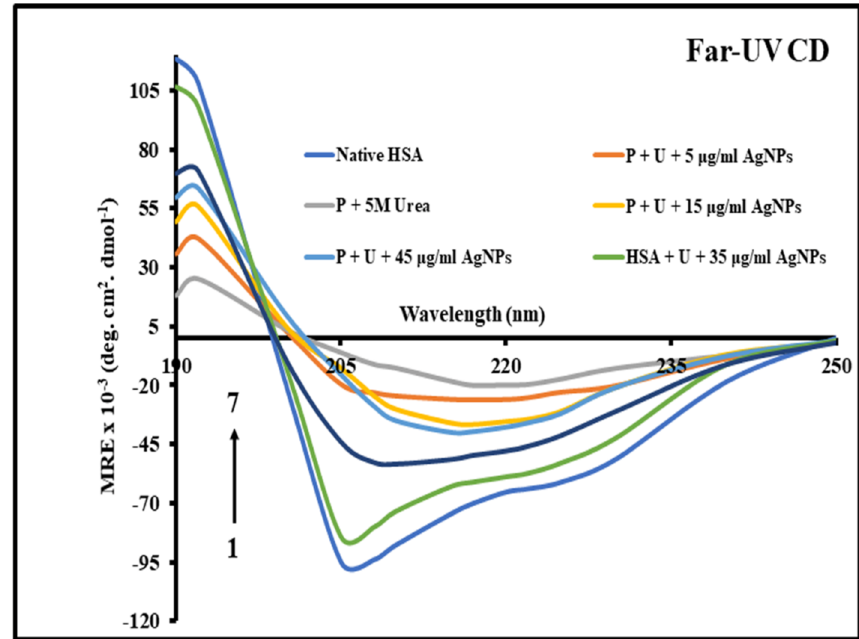
Figure 3. Far UltraViolet CD spectra of native HSA, HSA in the presence of 5 M urea, and HSA in the presence of increasing concentrations of B-AgNPs. Between 190 and 250 nm, the spectra were recorded. The final concentration of protein was 5 µM, and the path length was 0.1